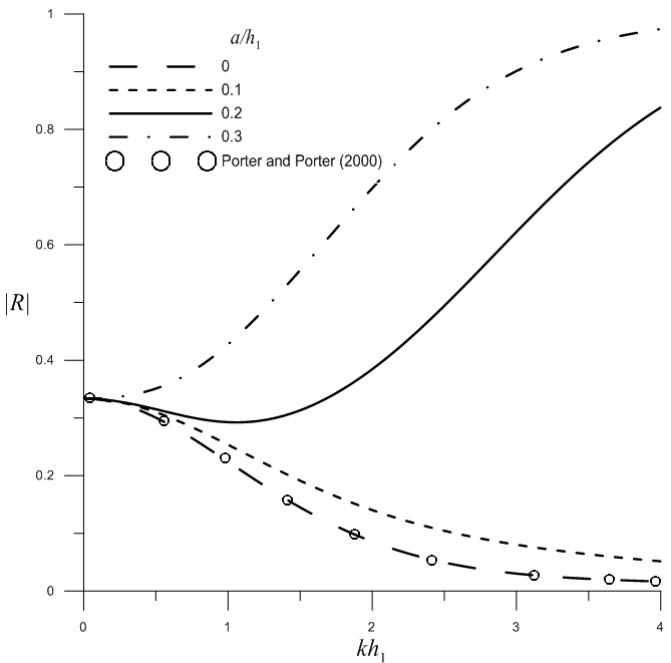
Figure 8. Reflection coefficient | R | varying against kh 1 for a single surface-piercing barrier of different barrier lengths.